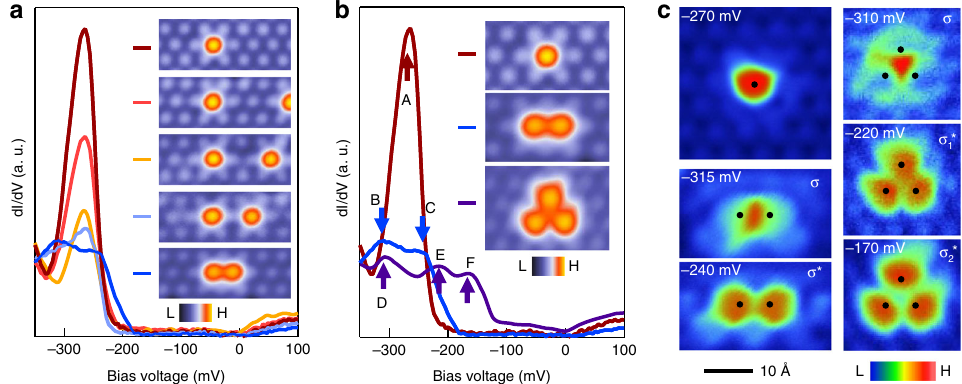
Fig. 3 Interacting impurity states induced quantized orbitals. a Differential conductance spectra taken at the central impurity with perturbations of varying strengths from a second impurity. Inset: respective topographic images for impurity con fi gurations. Note the images are acquired by fi nding different surface locations. b Local impurity state with coupling to different numbers of impurities. The arrows highlight the quantized splitting with additional interacting impurity numbers. Note the images are acquired by fi nding different surface locations. c dI/dV maps at the respective bound state energies in ( b ). dI/dV maps taken at V = − 270 mV for a single impurity; − 315 mV (bonding state σ ) and − 240 mV (antibonding state σ ) for a double impurity, respectively; − 310 mV (bonding state σ ), − 220 mV (antibonding state σ 1 *) and − 170 mV (antibonding state σ 2 *) for a triple impurity, respectively. The black dots mark the center of